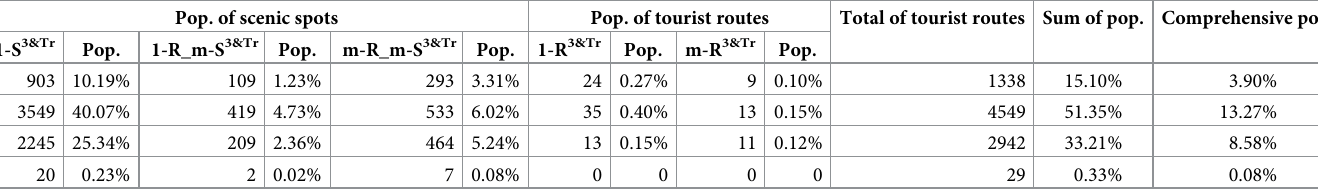
Table 4. Calculated results of TDP (abbreviated pop.) at Jiuzhaigou tourist route scales. Pop. of scenic spots Pop. of tourist routes Total of tourist routes Sum of pop. Comprehensive pop.